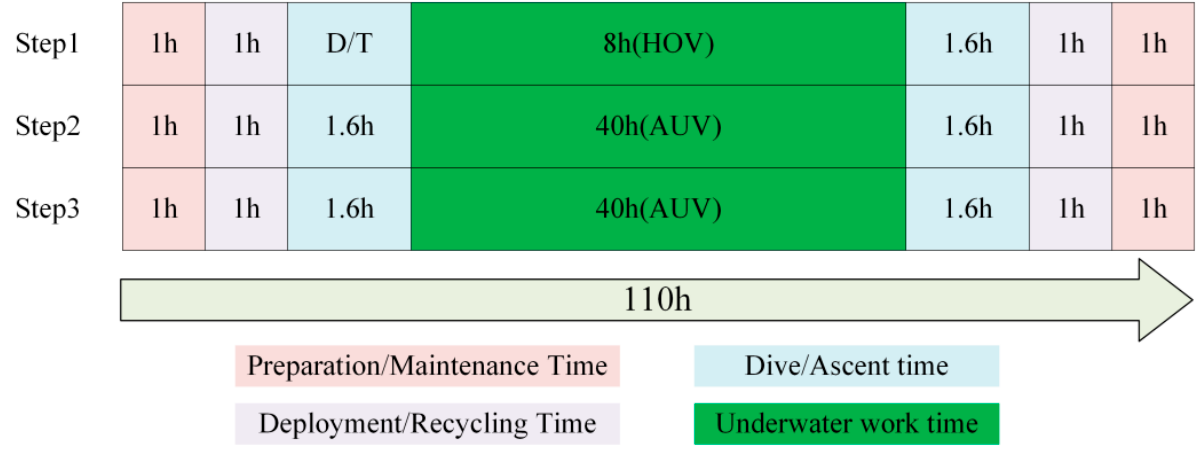
Figure 12. Elapsed time in traditional distributed operational mode (one HOV and Two AUVs).